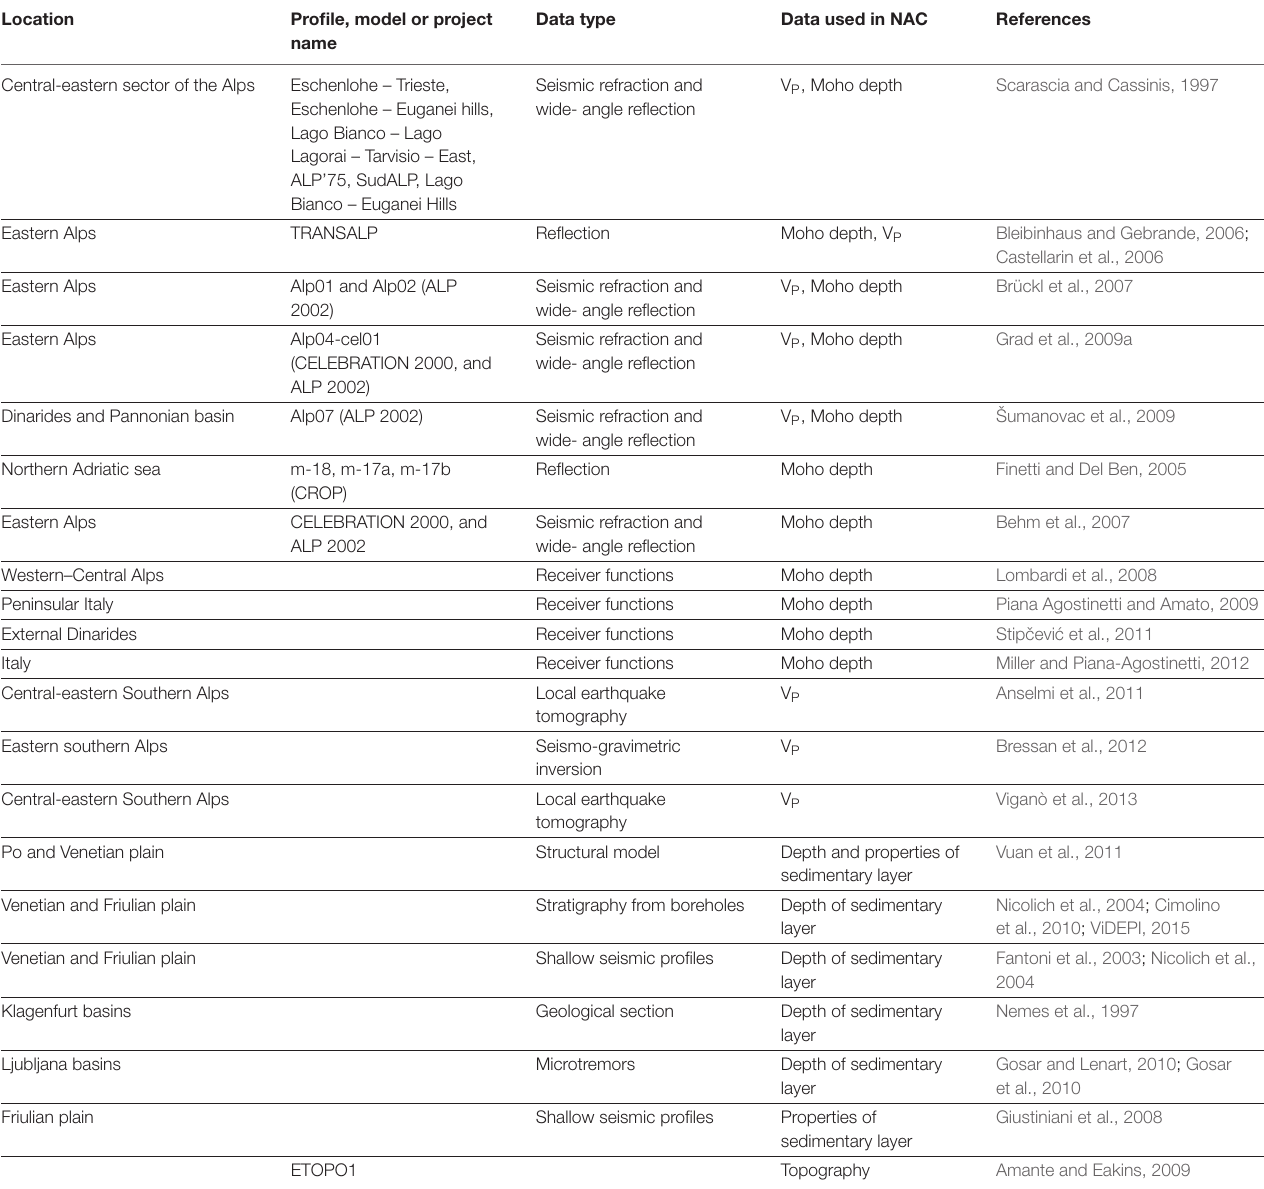
TABLE 1 | Data sources used in the construction of the